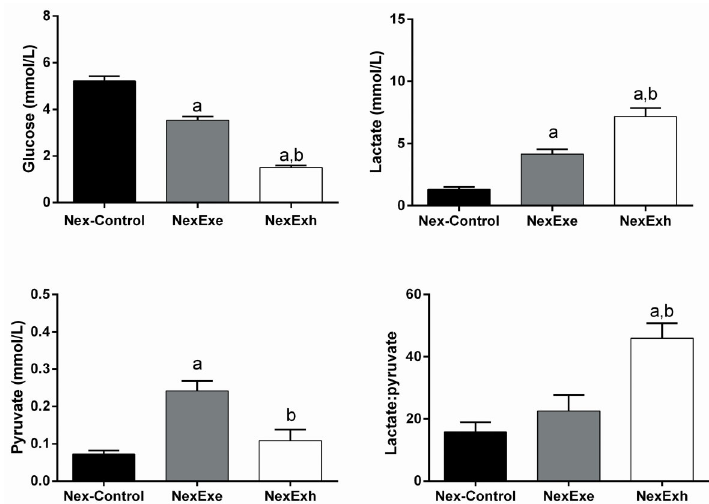
Figure 2. Plasma metabolites measurements in the never exposed (Nex) group. Effect of an acute strenuous swimming session on plasma glucose, lactate, pyruvate concentrations, and the lactate:pyruvate ratio in overnight fasted rats. Two rats were placed in the water tank. Once the fi rst rat reached exhaustion (NexExh), the second rat was immediately removed from water (NexExe). The control rats (Nex-Control) were placed in the water tank and immediately removed. Data are reported as means ± SE (n=7 animals per